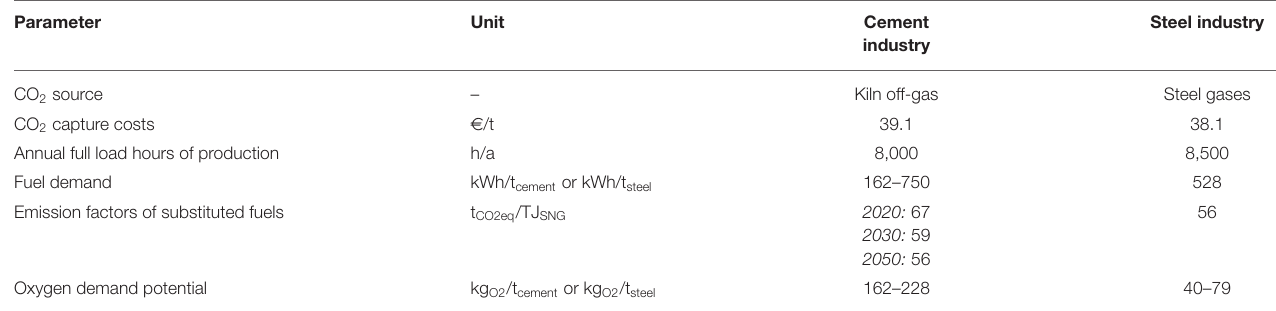
TABLE 1 | Scenario-specific calculation